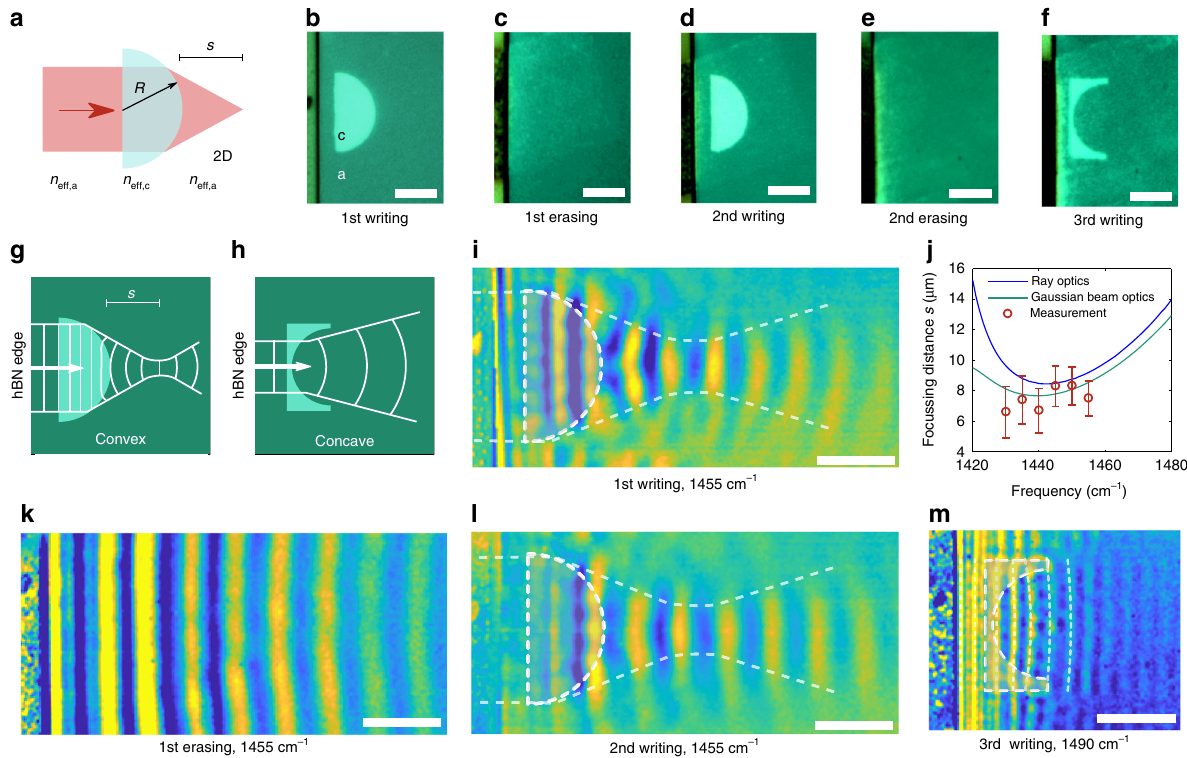
Fig. 2 Rewritable fl at polaritonic lenses. a Plano-convex lens schematics for 3D and 2D semi-spherical and semi-circular lenses. In the 2D case the material refractive index is replaced by the effective index of the polaritons on amorphous or crystalline GST. b – f Optical images of the written lens. The written patterns are clearly visible in the pictures because the refractive index of a-GST and c-GST also differs at visible wavelengths. First a plano-convex semi- circular lens (radius R = 5 µ m) is written and measured, then it is erased, re-written (with same dimensions), erased again and fi nally the same area is recon fi gured into a plano-concave lens ( R = 5 µ m). g , h Diagram of wavefronts for 2D plano-convex and plano-concave lenses, respectively. i s-SNOM image of the plano-convex lens after the fi rst writing. A focal spot is clearly visible. j Dependence of the focal length on the wavenumber. Error